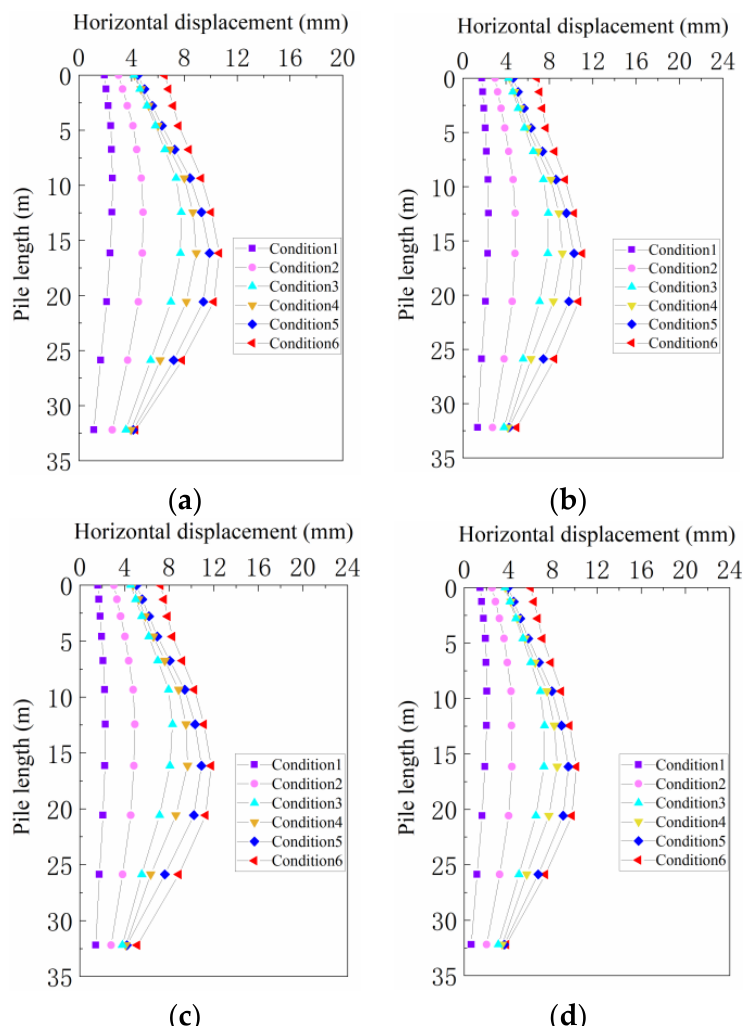
Figure 14. Distribution of horizontal displacement of the bridge pile along the short side of the foundation excavation. ( a ) Point A; ( b ) Point B; ( c ) Point C; ( d ) Point D. By comparing working condition 5 (excavating to the bottom without the train load) and working condition 6 (applying the train load when excavating to the bottom) of each pile, the train load increased the horizontal displacement of the pile foundation along the short-side direction of the foundation excavation. The dynamic load had little influence on the maximum horizontal displacement of the pile body, and the main influence was still reflected in the position of the pile